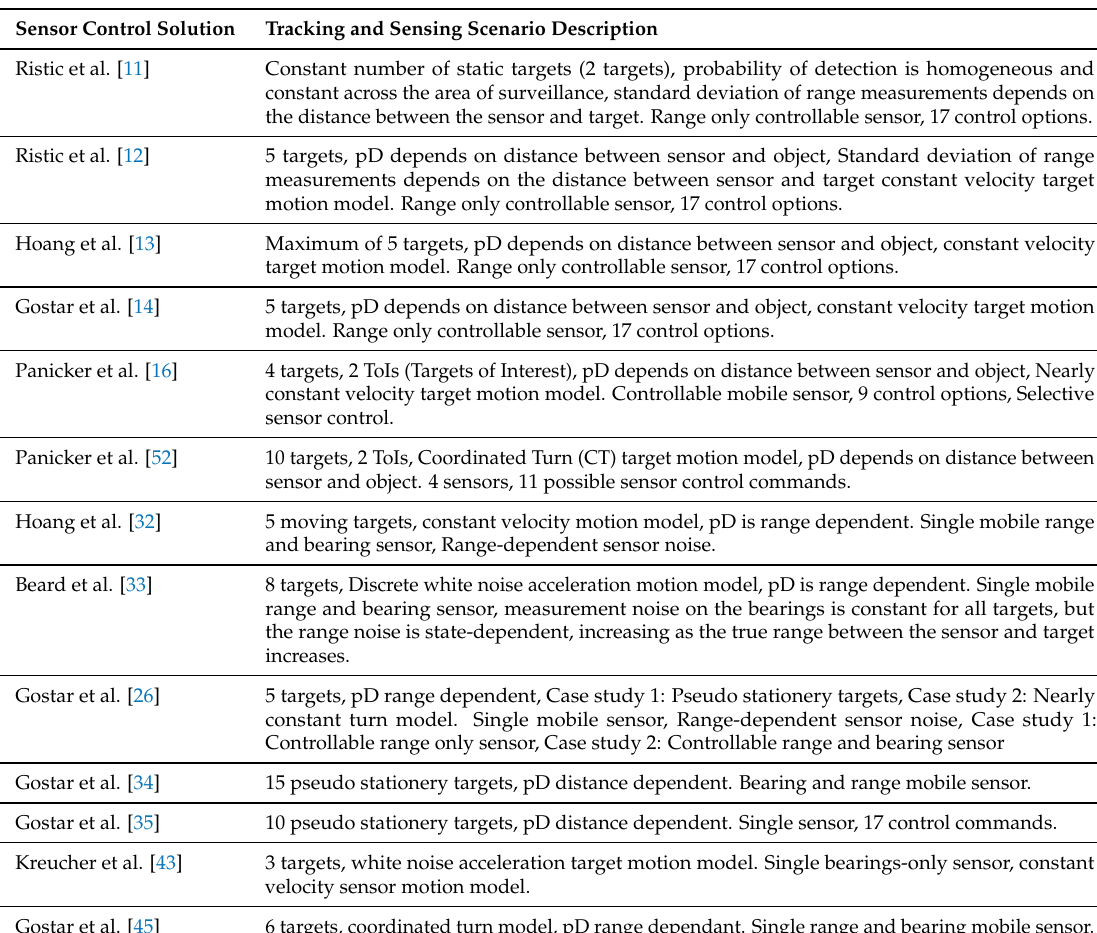
Table 2. Sensor control scenarios in the recent sensor control and target tracking literature. Sensor Control